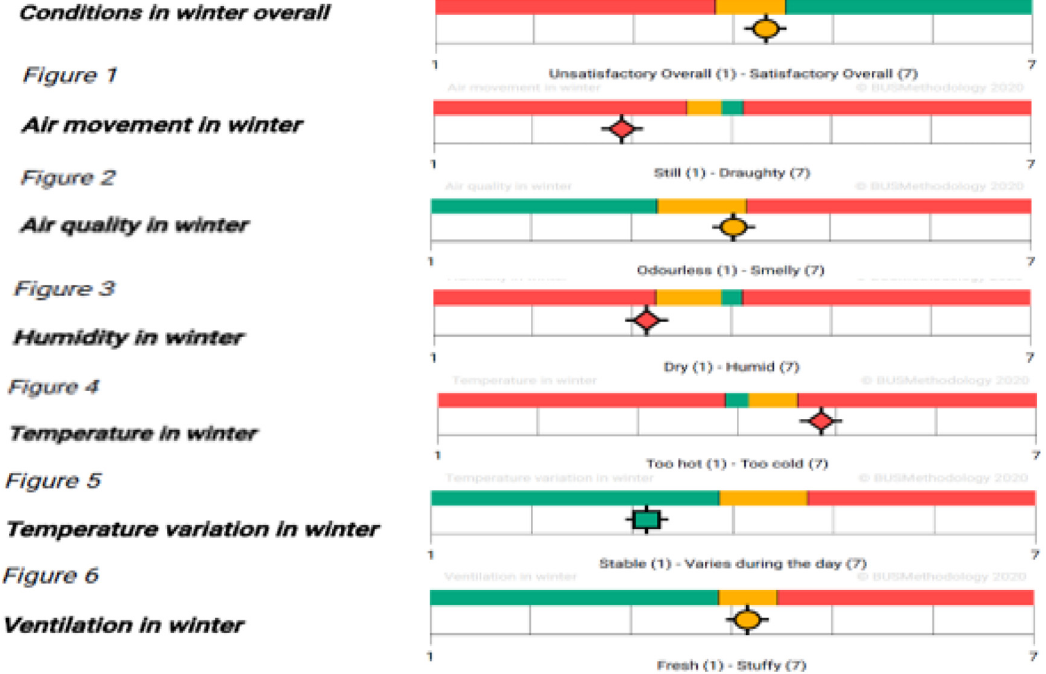
Fig. 6. Question mean response of conditions in winter relative to the benchmark